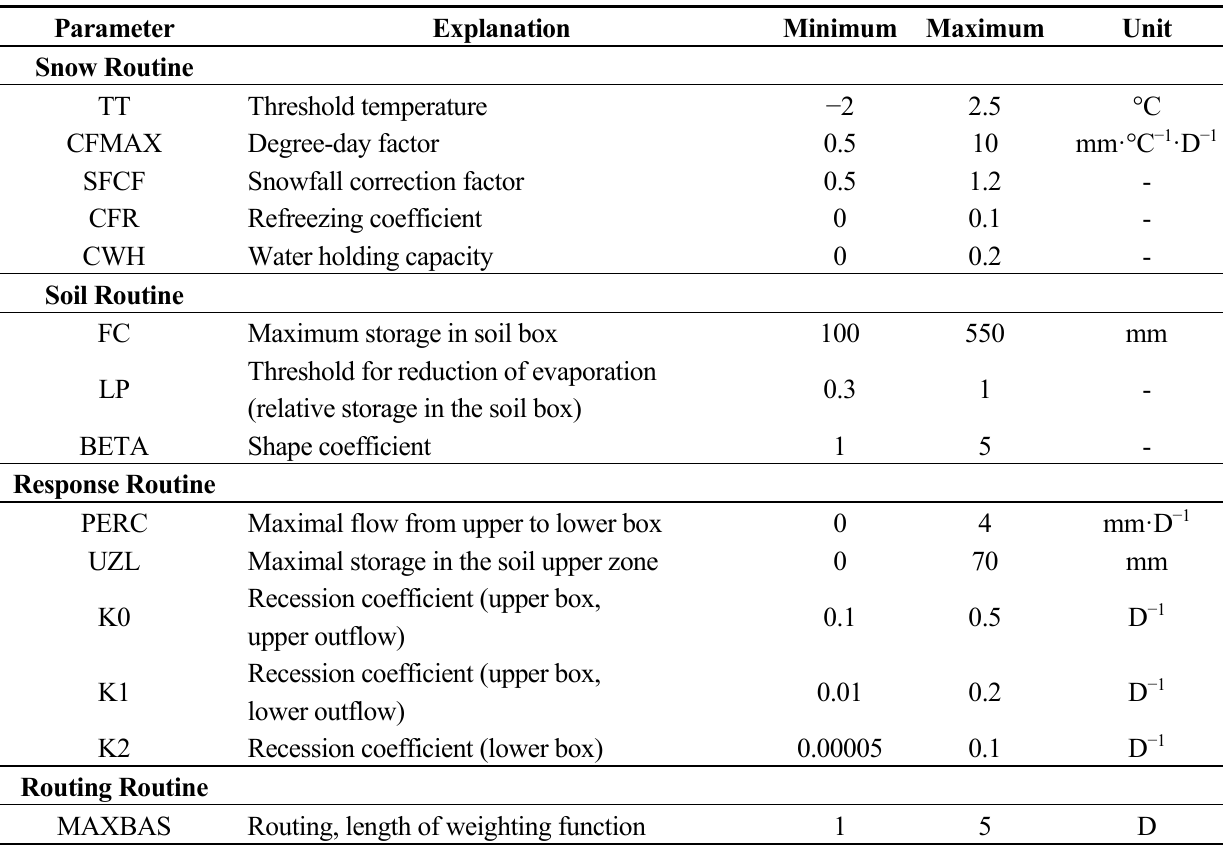
Table 2. Parameter ranges used during the Genetic Algorithm and Powell optimization